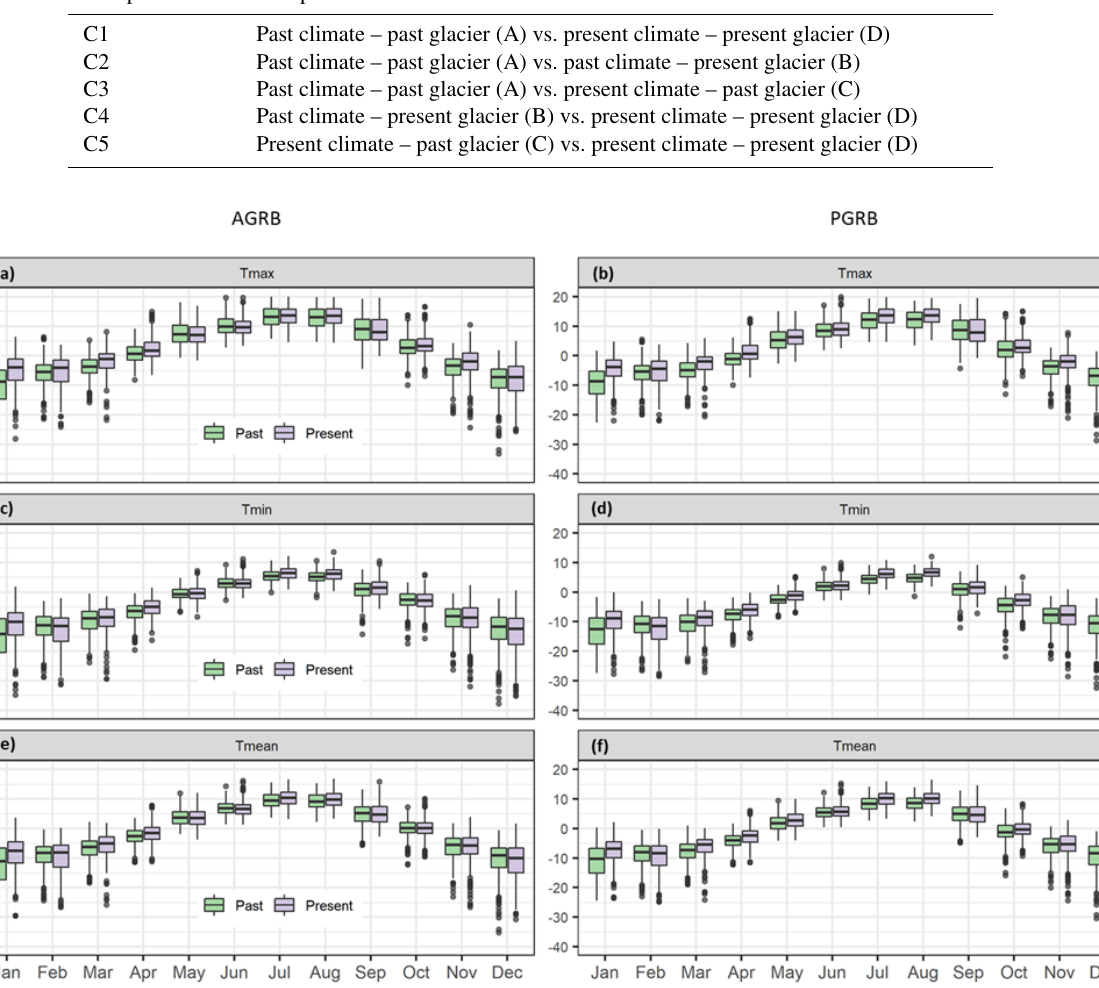
Table 1. Comparison of model outputs. Comparison no.